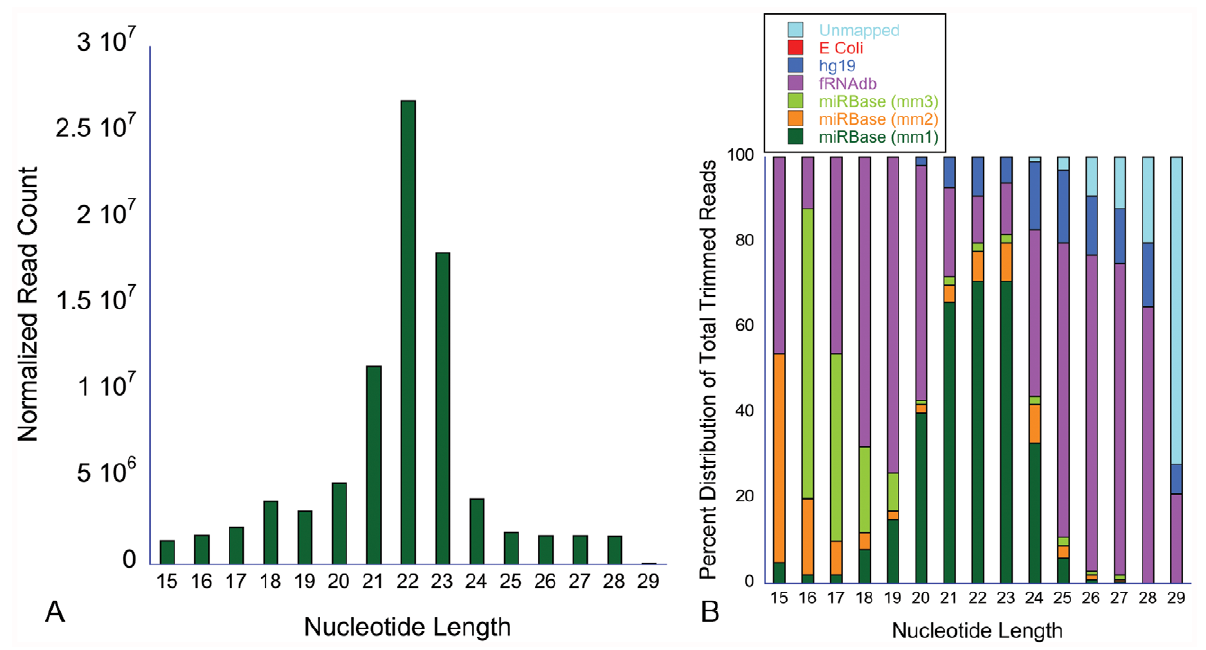
Figure 2. Normalized read counts and their distribution according to the nucleotide length. Fig. 1A shows that majority of trimmed reads were 21–23 nucleotides in length, the same size as miRNA. Fig. 1B shows the distribution of trimmed reads based on their mapping to miRNA, human genome, non-coding RNA (besides miRNA etc) and E coli genome. mm1, mm2 and mm3 represent alignment to miRBase with 0 or 1, 2 and 3 mismatches respectively. Note that the majority of aligned miRNA with 0 or 1 mismatch are distributed around 22 base pairs, the expected size of